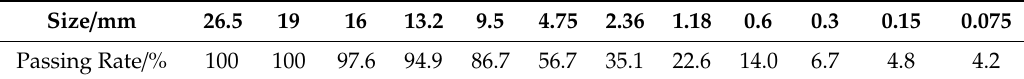
Table 2. Gradations of RAP.